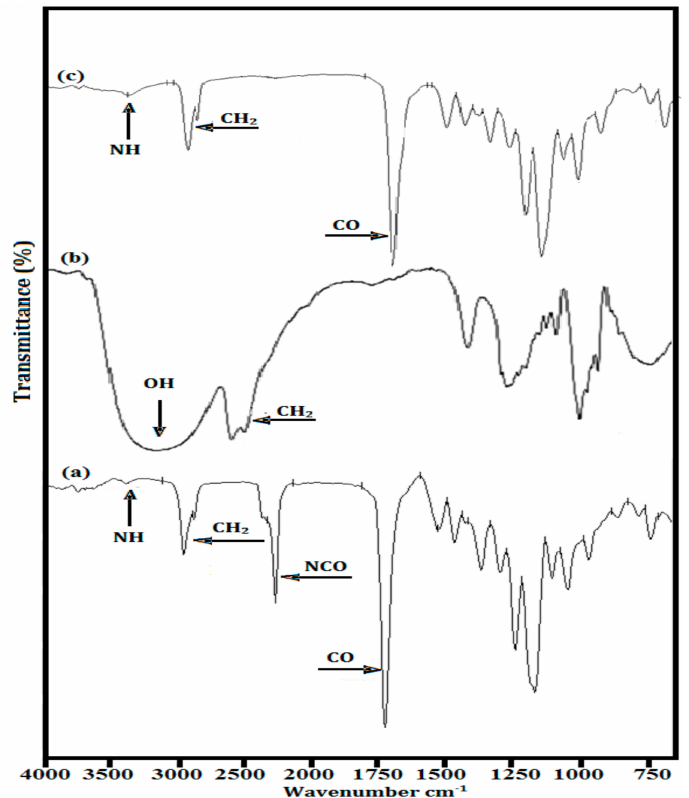
Figure 2. FTIR spectra of ( a ) pre-polymer, ( b ) HDO and ( c )